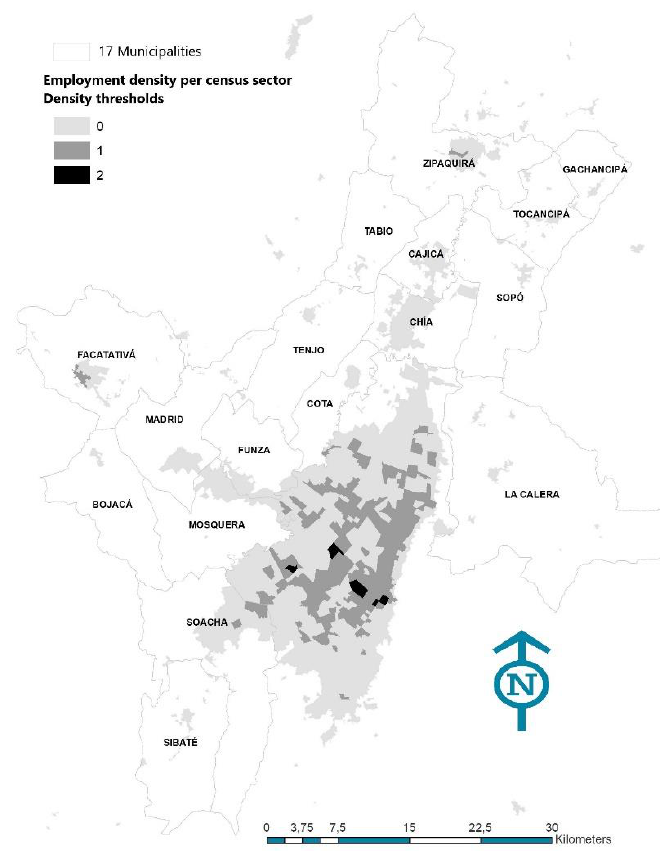
Figure 4. Employment densities in Bogotá and 17 municipalities, 2017, using methodology pro- posed by [44]. Based on information from the EEEBR (2017). by [44]. Based on information from the EEEBR